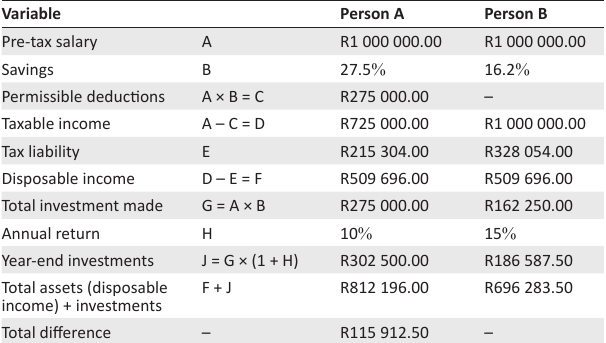
TABLE 1-A2: Increased contribution